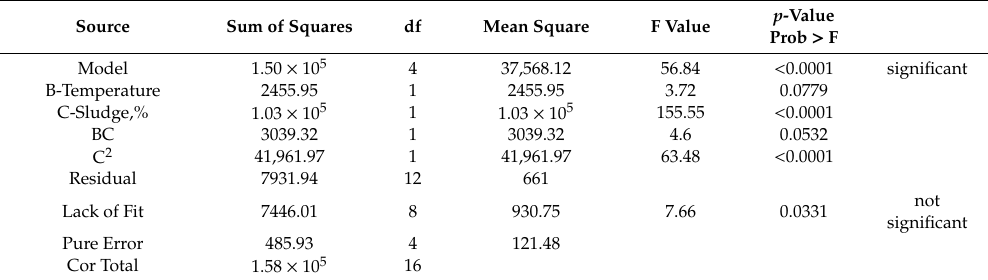
Table 12. ANOVA table for biogas production by AD of spent grain and pot ale quadratic model α = 0.01.